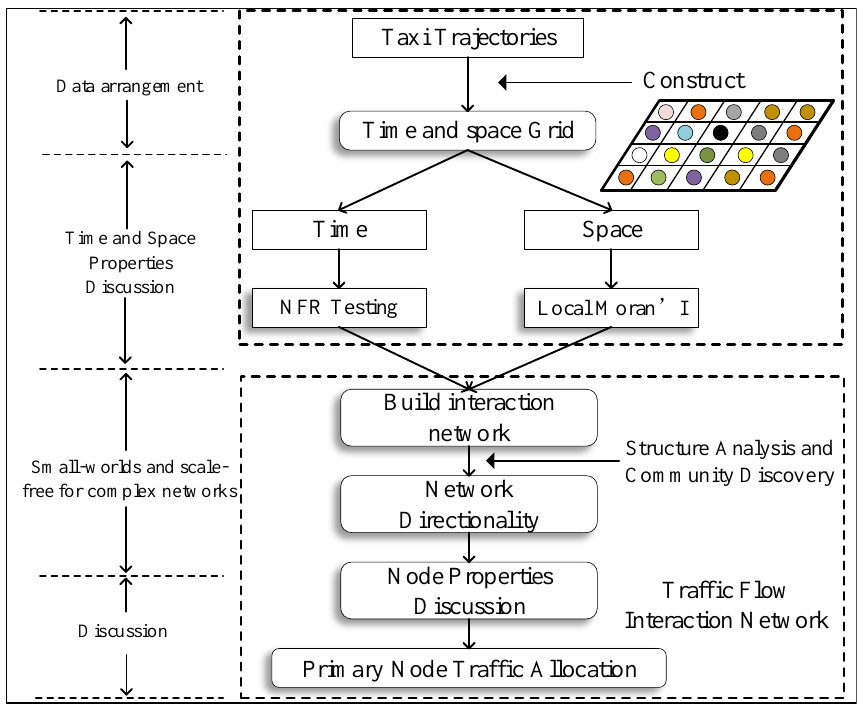
Figure 3. Method flow